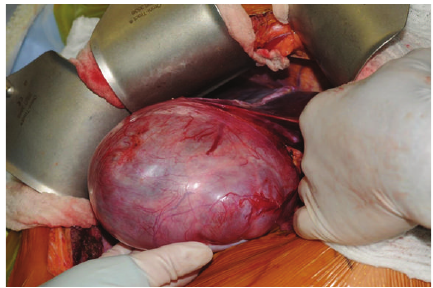
Figure 4: Name: mobilization of the biliary cystadenoma prior to resection. Description: the massive biliary cystadenoma, measuring 18 cm across, was mobilized to reveal the extent of hepatic involve- ment prior to